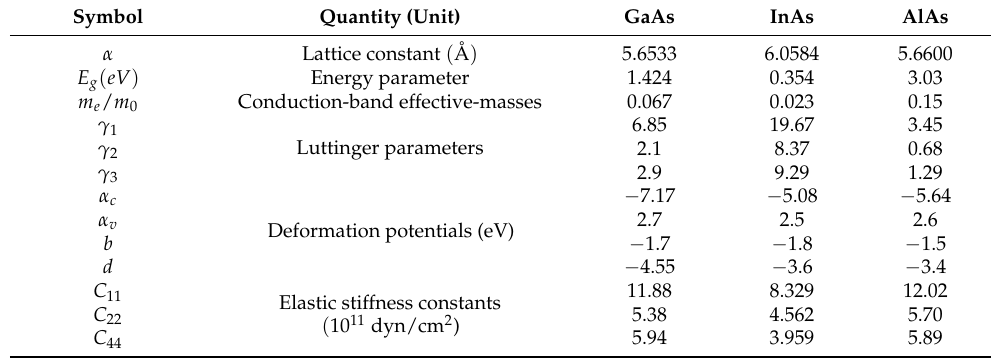
Table 1. Material parameters used in the calculation. Adapted with permission from